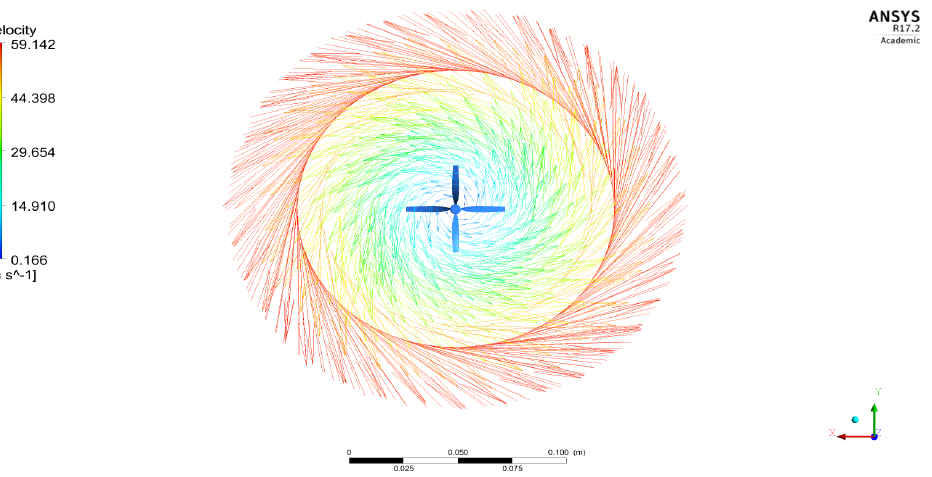
Figure 48. A typical vector representation of hydrodynamic velocity variations over the UAV pro- peller under the conditions of 3 m/s and 8000 RPM.